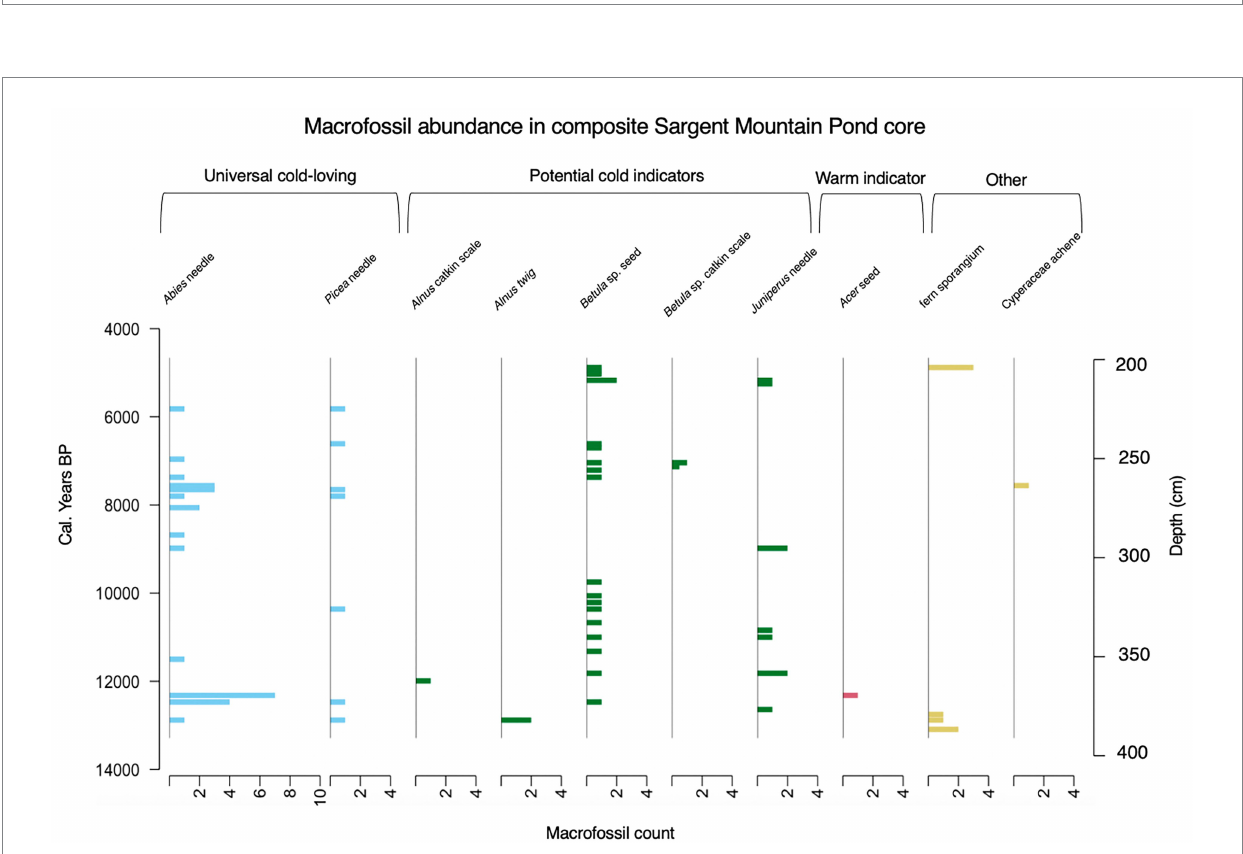
FIGURE 4 Plant macrofossil abundance from 13,290 BP to 4,660 BP (390–200 cm). Blue shaded graphs show counts of macrofossils of universal cold-loving species, green shaded graphs show counts of macrofossils that are potential cold indicators, pink shaded graphs show counts of macrofossils from warm indicator species, and yellow shaded graphs show counts of other, non -indicator species. Unidentifiable fragments of leaves and twigs were also collected in this core but, as they had no diagnostic characteristics, are not included in the stratigraphy. We also found evidence of Daphnia and Chara as well as other aquatic organisms, but the aquatic community in the lake is beyond the scope of this paper. We used the R package rioja (Juggins, 2020) to make this